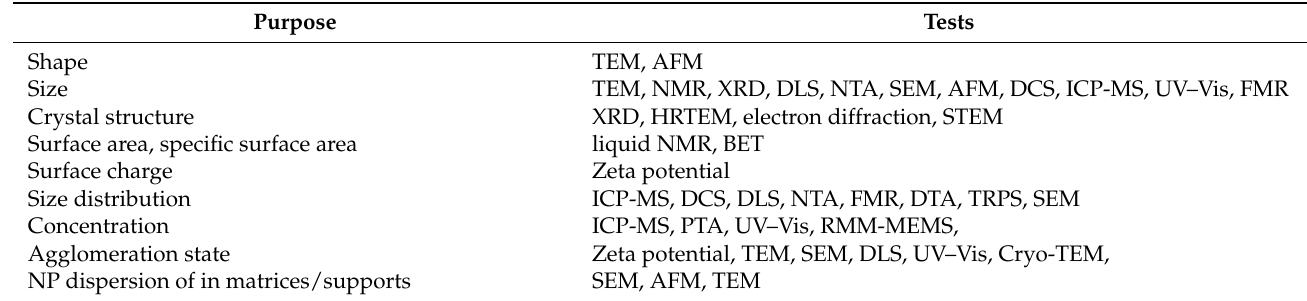
Table 1. A list of common tests employed in food packaging